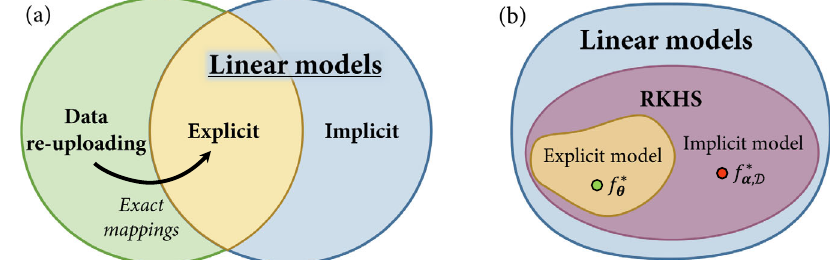
Fig. 2 | The model families in quantum machine learning. a While data re- uploading models are by de fi nition a generalization of linear quantum models, our exactmappingsdemonstratethatanypolynomial-sizedatare-uploadingmodelcan be realized by a polynomial-size explicit linear model. b Kernelizing an explicit model corresponds to turning its observable into a linear combination of feature states ρ ( x ), for x in a dataset D . The representer theorem guarantees that, for any